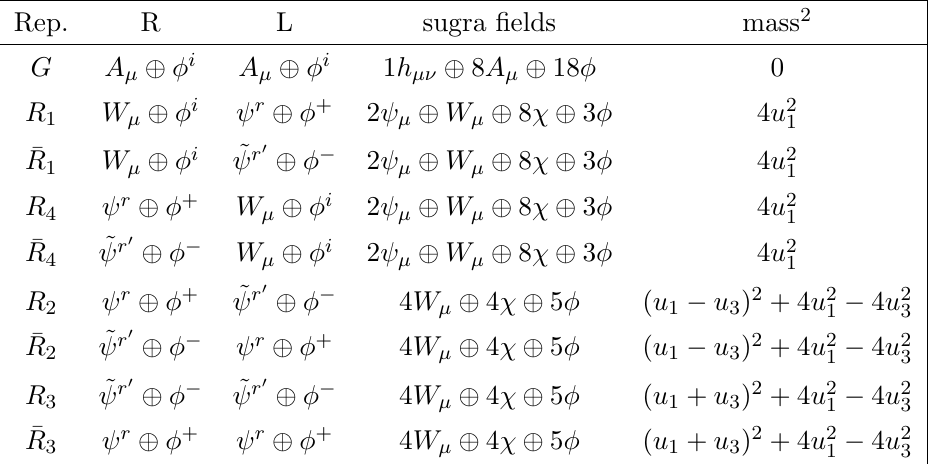
Table 6 . Spectrum of the explicitly-broken theory with SO(4) (cid:2) U(1) 2 unbroken gauge symmetry and no residual